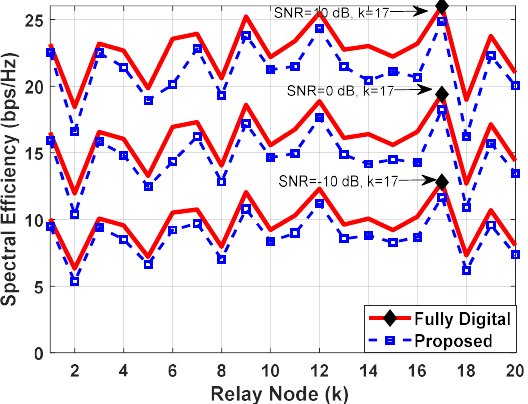
Figure 4. Spectral efficiency vs. relay nodes in a mm-Wave propagation environment with UPA such that 𝑁 (cid:3030)(cid:3039) = 4,𝑁 (cid:3045)(cid:3028)(cid:3052) = 10 and 10 (cid:3042) spread angle. System parameters are set as 𝑁 (cid:3047) = 𝑁 (cid:3045)(cid:3032)(cid:3039) = 100,𝑁 (cid:3045) = 25,𝑁 (cid:3046) = 4 with the assumption that the number of RF-chains is equal to the number of data streams 𝑁 (cid:3047)(cid:3019)(cid:3007) = 𝑁 (cid:3045)(cid:3019)(cid:3007) = 𝑁 (cid:3045)(cid:3032)(cid:3039)(cid:3019)(cid:3007) = 𝑁 (cid:3046) . There are 20 active relay nodes between the source and the destination for the selection of the best relay.